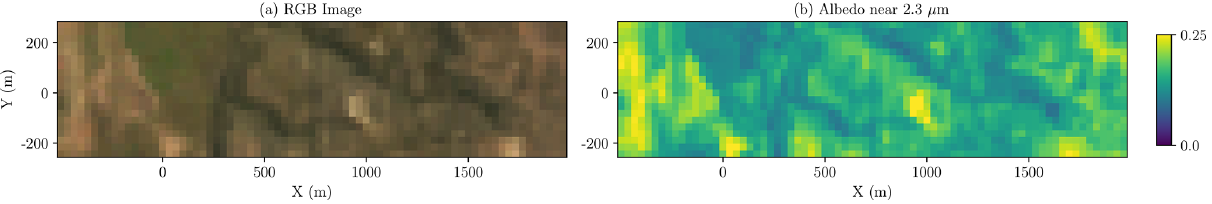
Figure 15. RGB and 2.2µm albedo images of a realistic surface distribution in the Durango area, Colorado, from LANDSAT.